Question: Sum up the contents of this chart in one sentence.
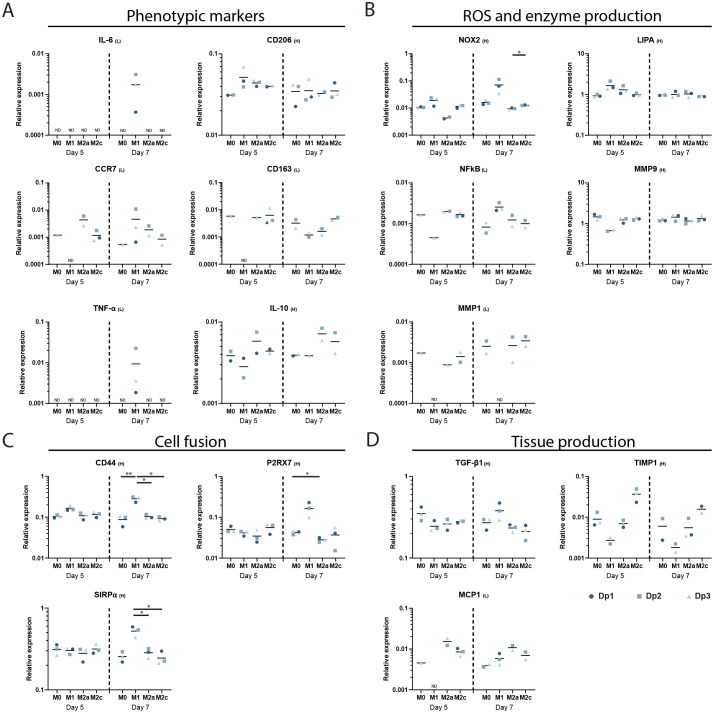
Answer: Effect of macrophage polarization on foreign body giant cell (FBGC) polarization. Genes related to phenotype (A) , reactive oxygen species (ROS) and enzyme production (B) , cell fusion (C) , and tissue production (D) were measured. Gene expression relative to housekeeping genes. ( H ) and ( L ) depict dilution of cDNA by 60x or 30x respectively. Samples depicted with ND showed no signal or too high variability between technical replicates. Day 5 represents five days of interleukin-4 (IL-4) induced fusion after polarization and day 7 represents two days of re-polarization of FBGCs. All lines in the figures show mean value with each shape representing a different donor pool (Dp1-3; n=3 biological replicates). * p < 0.05.